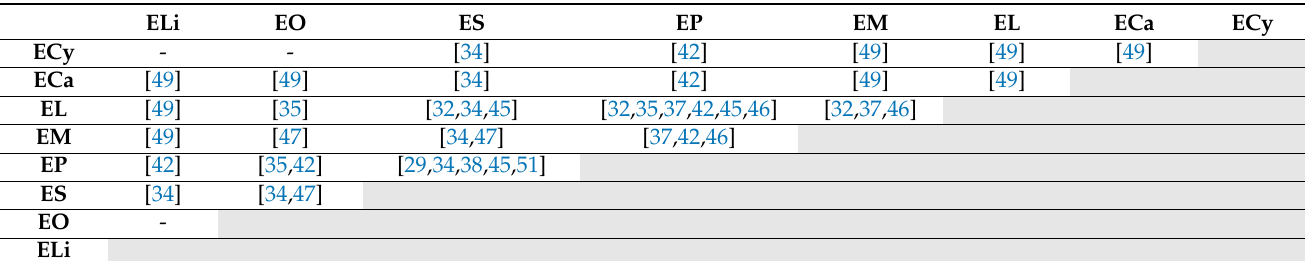
Table 4. References described in Section 2.1, ordered by the two compounds of the mixture 1